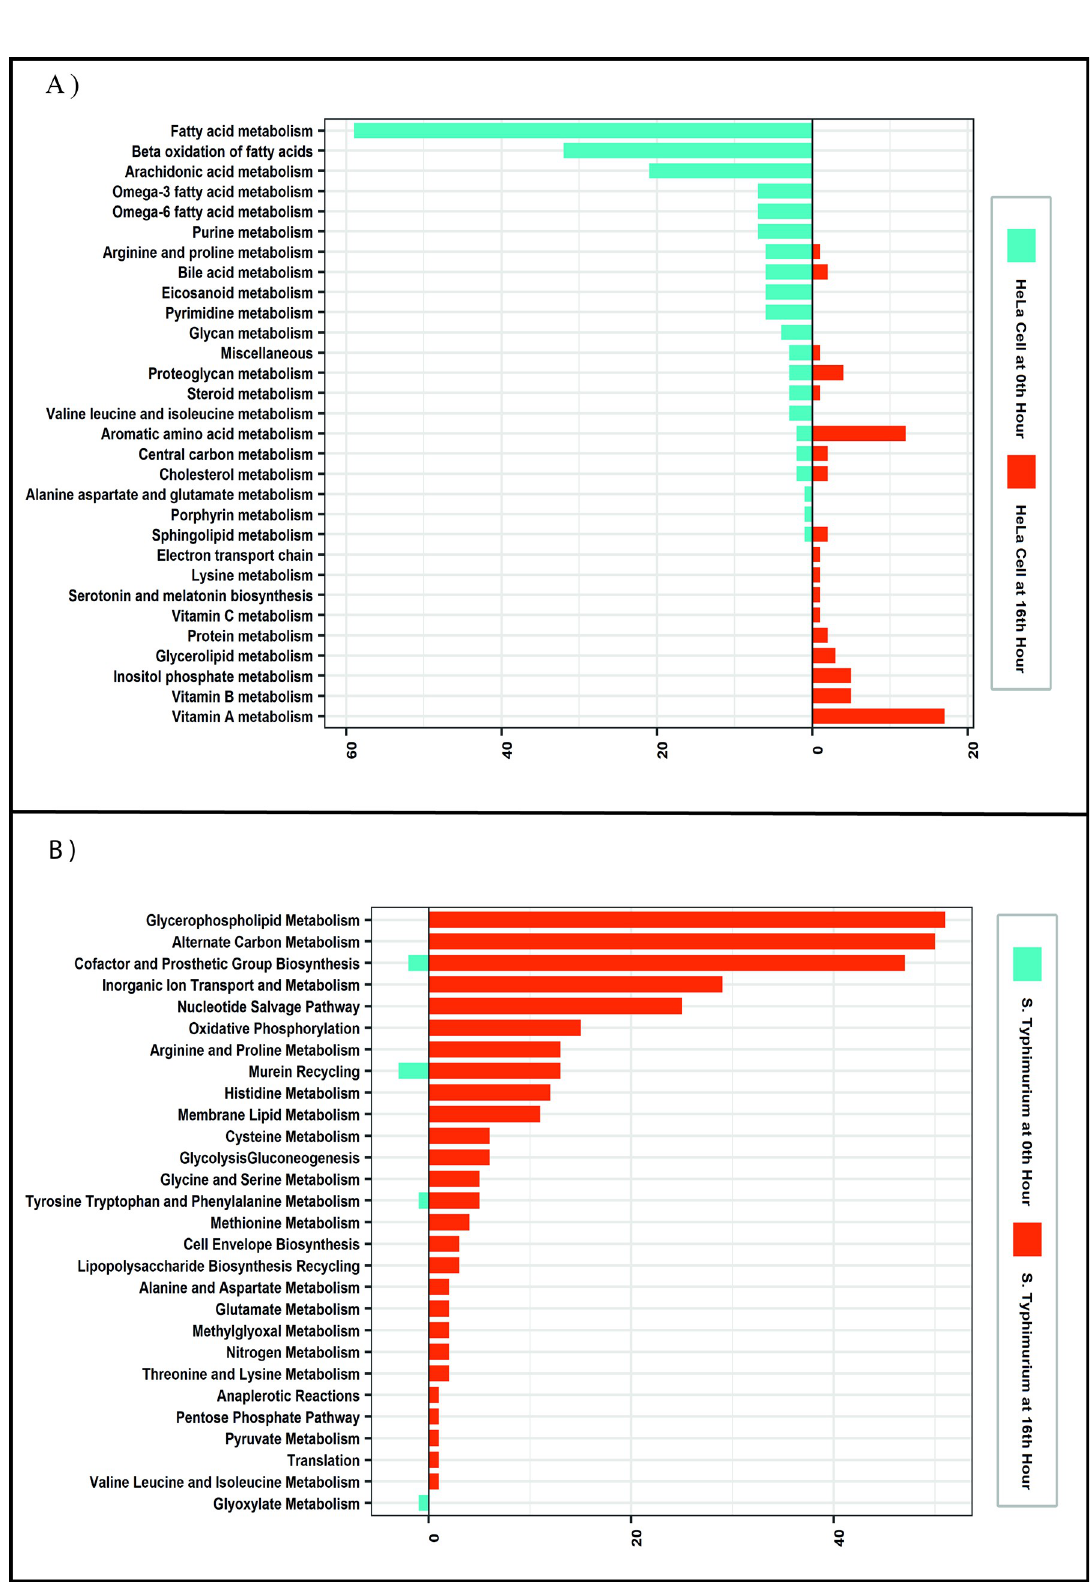
Fig 1. The differences in reaction profiles of condition-specific pathogen-host GMNs grouped by pathways. Pathways with at least 2 differential reactions are given. Red and green bars represent the number of HeLa cell reactions that are only active in 0 th hour and 16 th